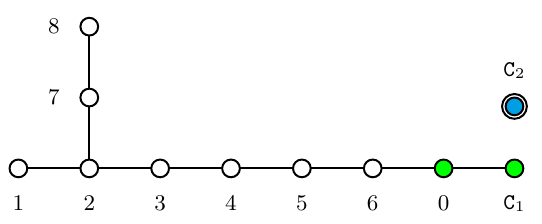
Figure 2 . Generalized Dynkin diagram giving enhancements (G 9 ) 2 + (A 1 ) 1 . Green (blue) coloring means that the state has nontrivial momentum number and/or winding only along direction 1